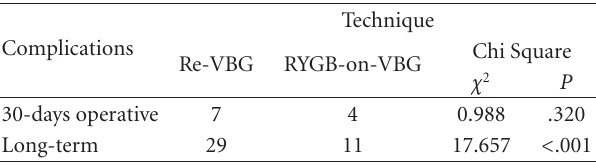
Table 7: Outcomes of revisionary surgery for failed or complicated VBGs: chi-square test applied to compare 30-day operative and long-term